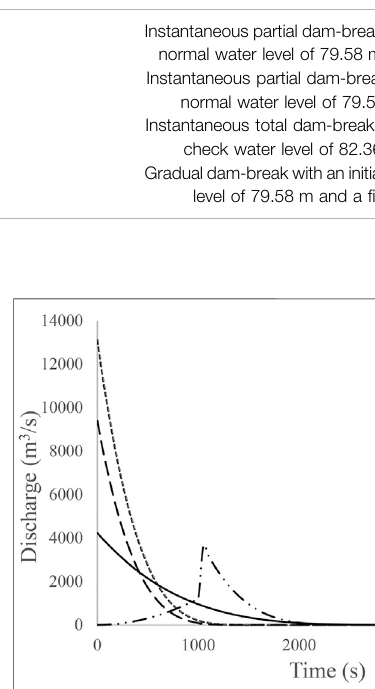
TABLE 1 | Four different failure conditions. Failure condition Detailed information